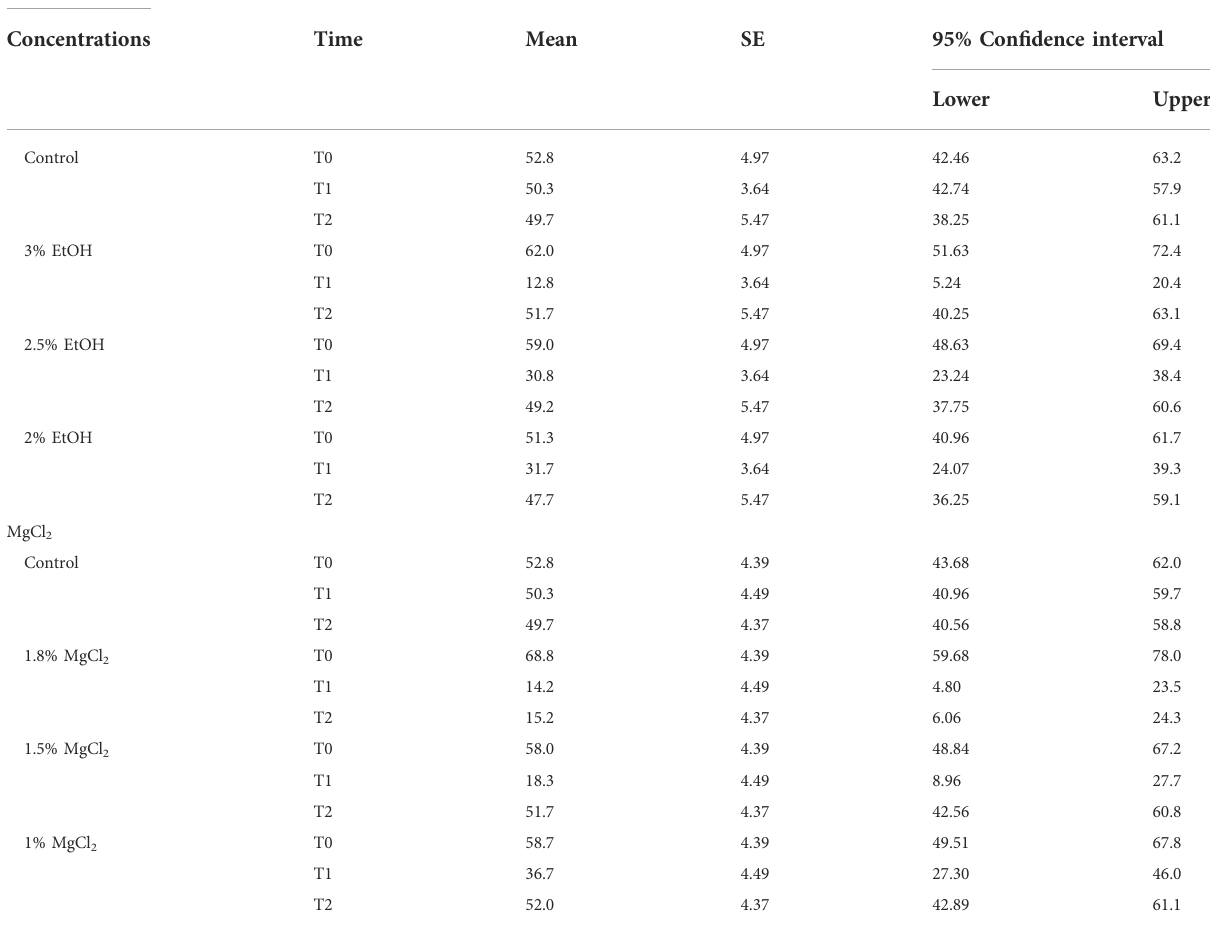
TABLE 2 Respiratory rate (mantle contractions/minute) of L. vulgaris embryos exposed to different EtOH and MgCl 2 concentrations and the controls (noanesthetic solution).Measures aresummarized (mean,SE,and95%con fi denceinterval)atthethreedifferentphases:baseline,t0;anesthesia, t1; and recovery,